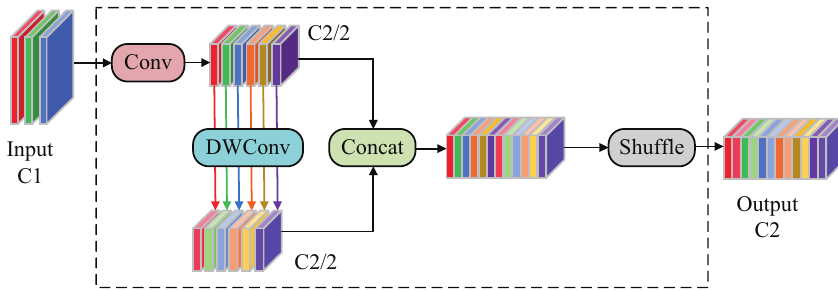
Figure 5. Schematic diagram of GSConv